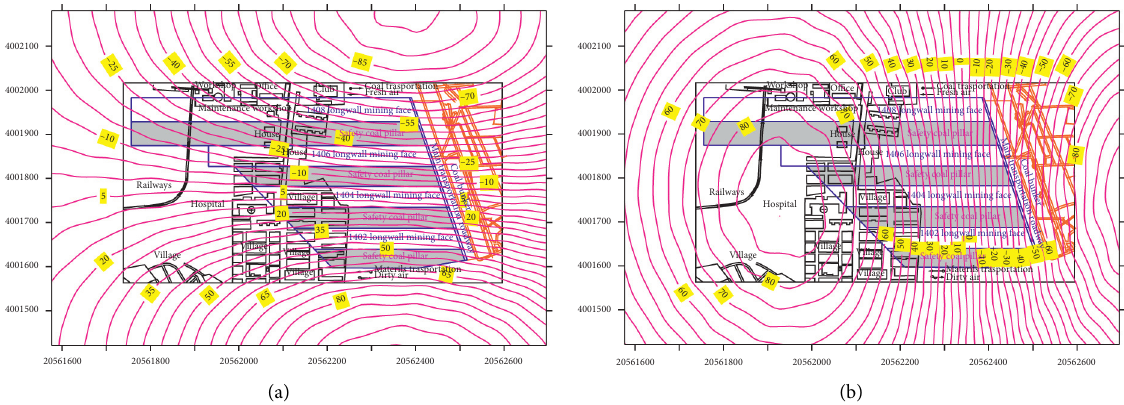
Figure 13: Contour map of horizontal surface movement in strip mining.